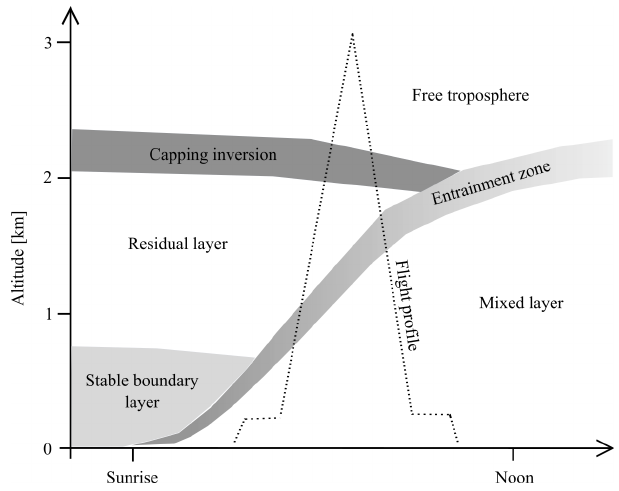
Figure 2. A schematic diagram of an average flight profile in rela- tion to BL